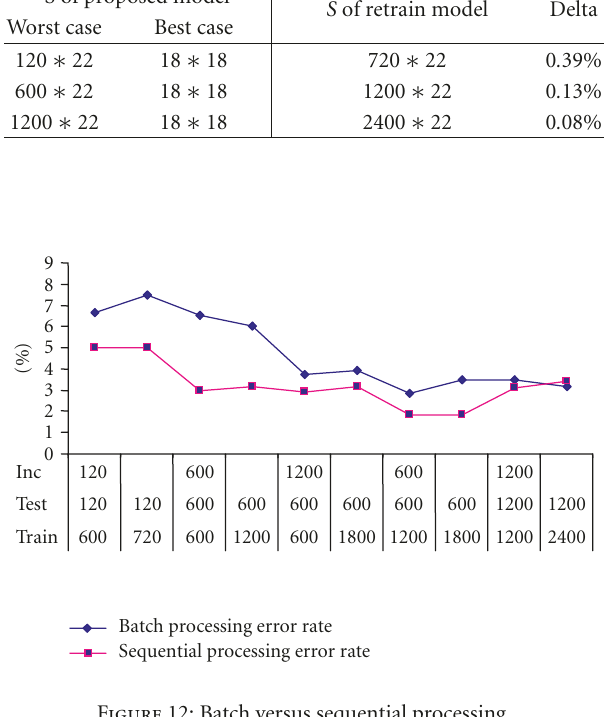
Figure 12: Batch versus sequential processing.